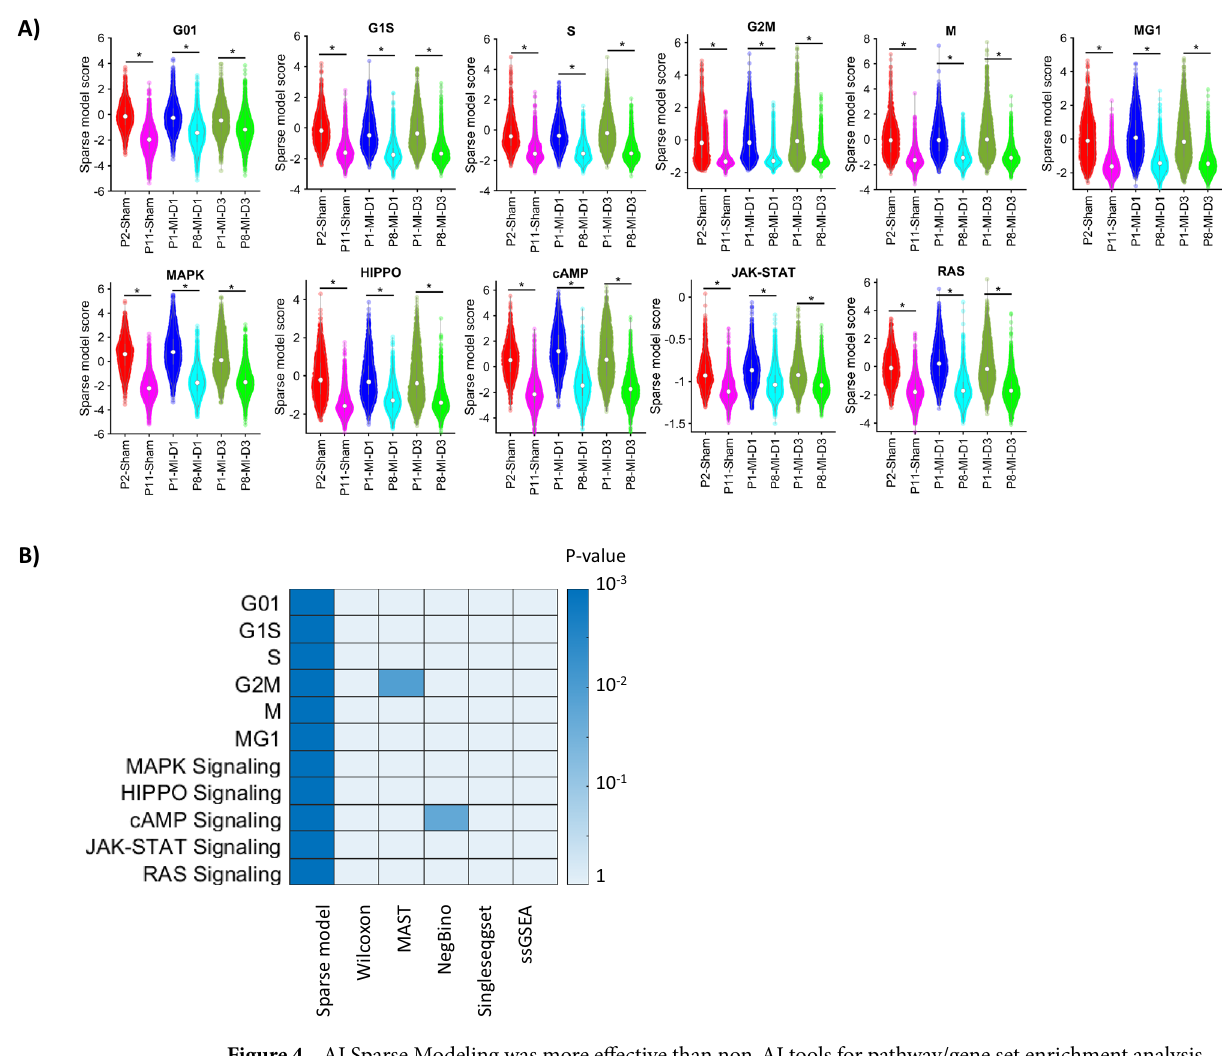
the expression of three genes (TBX5 68,69 , TBX20 70,71 , and ERBB4 72 ) that contribute to the proliferation of cardio- myocytes in fetal and neonatal mouse hearts. Collectively, these observations suggest that AR on P1 preserved some neonatal-like proliferative capacity in a subpopulation of cardiomyocytes that subsequently formed the CM1 cluster, and that MI on P28 triggered this latent proliferative capacity, thereby driving the transformation of CM1 cardiomyocytes into either CM2 or CM10 cardiomyocytes. Trajectory analysis via our AI Semisupervised learning model 73,74 tracks the transformation of one type of cell (e.g., CM1) into two other cell types (e.g., CM2 and CM10), via a procedure that is analogous to AI Sparse Modeling for pathway and geneset enrichment, with the two endpoints of the transformational trajectories serv- ing as the predefined positive (CM2, y = 1) and negative (CM10, y = − 1) cells. The w coefficients and b parameters were initially computed by applying formulas 2–4 to the cells at the endpoints of the trajectories (CM2 and CM10) and then used to calculate y (via formula 2) for each cell at the beginning of the trajectory (CM1). CM1 cells for which y > 0.1 were categorized as CM1 → 2, CM1 cells for which y < − 0.1 were categorized as CM1 → 10, and all other CM1 cells were categorized as inconclusive; then, CM2 cells were combined with CM1 → 2 cells (CM2 + 1 → 2), CM10 cells were combined with C1 → 10 cells (CM10 + 1 → 10), w and b were re-computed via